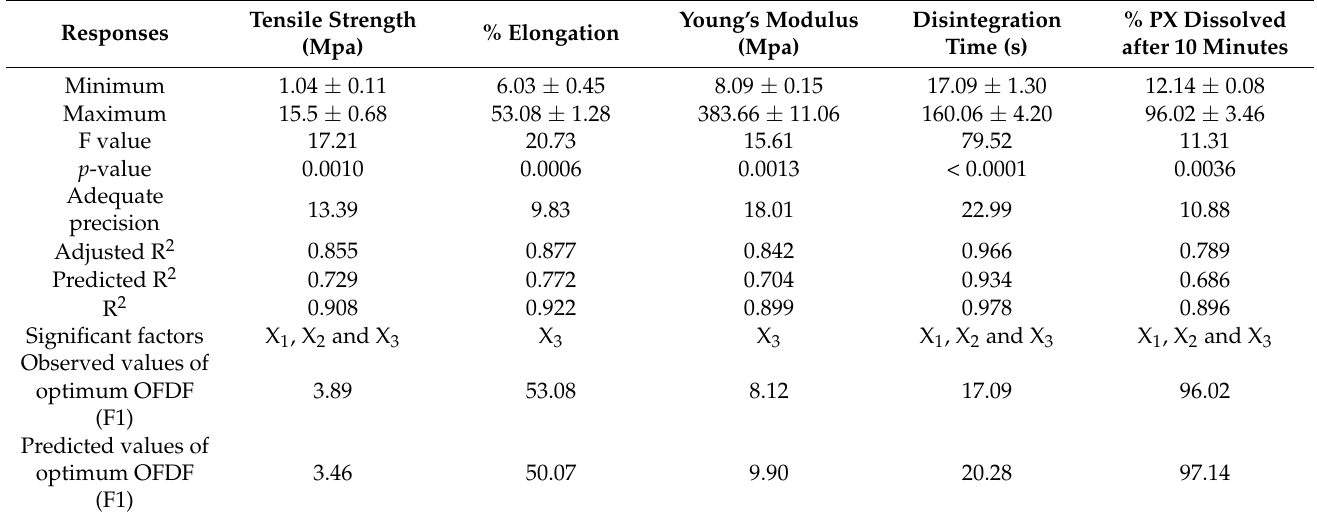
Table 2. Output data of the factorial design and predicted and observed values for the optimized OFDF (F1).